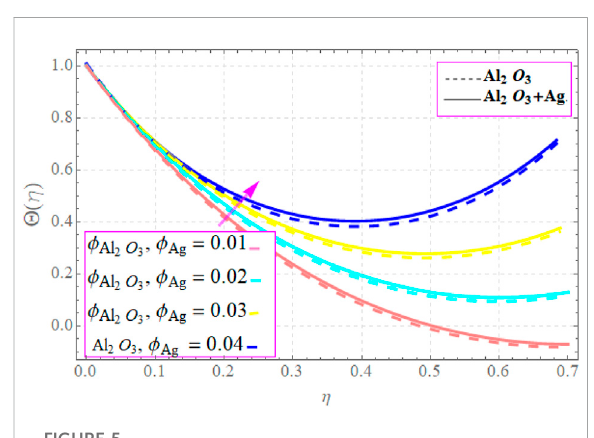
FIGURE 5 In fl uence of ϕ Al